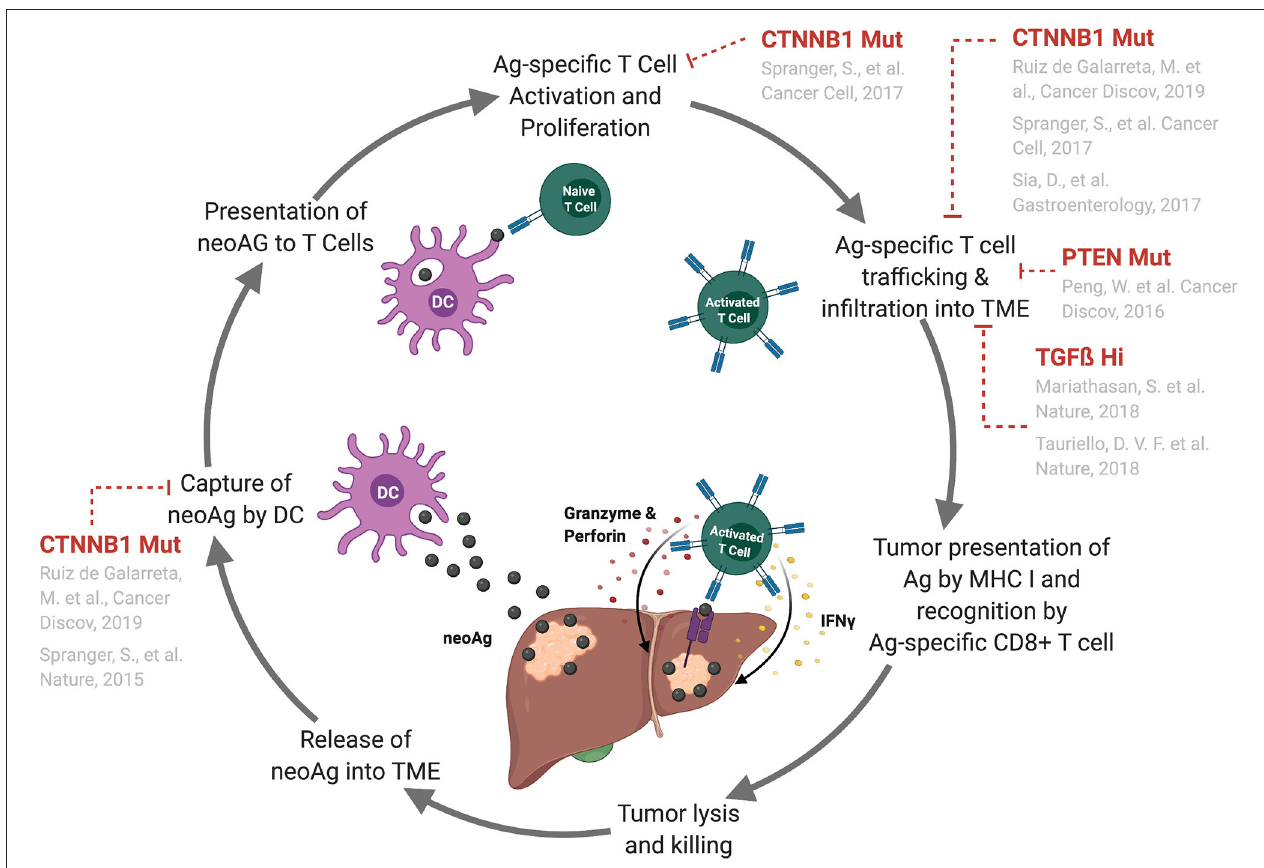
FIGURE 1 | Genetic alterations that perturb the cancer–immunity cycle and lead to tumor immune escape. Depiction of the cancer-immunity cycle (13). Tumor cells release antigens into the tumor microenvironment where they are sampled by circulating antigen presenting cells (APCs), such as dendritic cells. These APCs traffic to the lymphoid organs where they present antigens to T cells leading to T cell priming and activation. These activated T cells traffic back to the tumor site where they infiltrate, recognize, and kill tumor cells expressing their cognate antigen. Known mechanisms of immune escape in HCC and other tumor types that perturb specific points in this process are indicated. Abbreviations are as follows: neoAg, neoantigen; TME, tumor microenvironment; DC, dendritic cell; Ag,